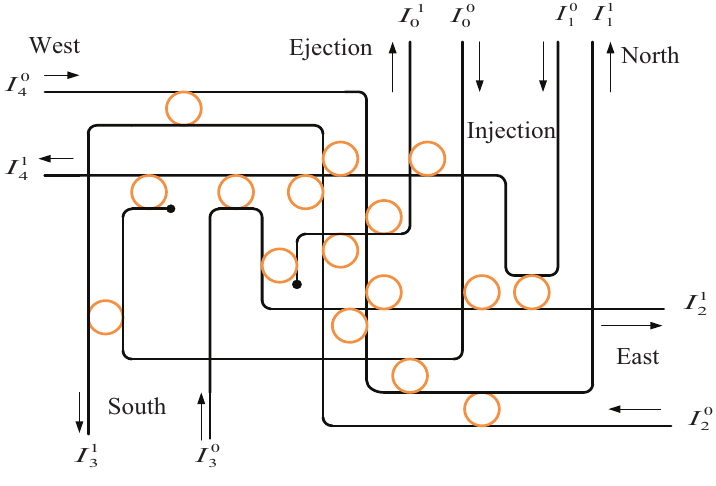
Figure 3. Five-port non-blocking router